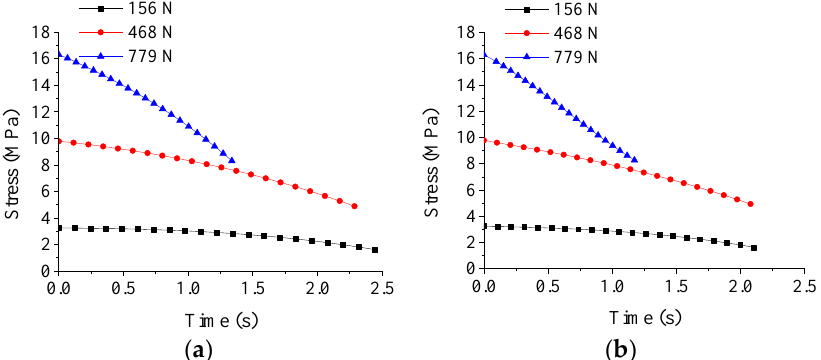
Figure 8. The variations of stress with time under different pressing forces at the following molding temperatures: ( a ) 382 °C and ( b ) 392 °C.